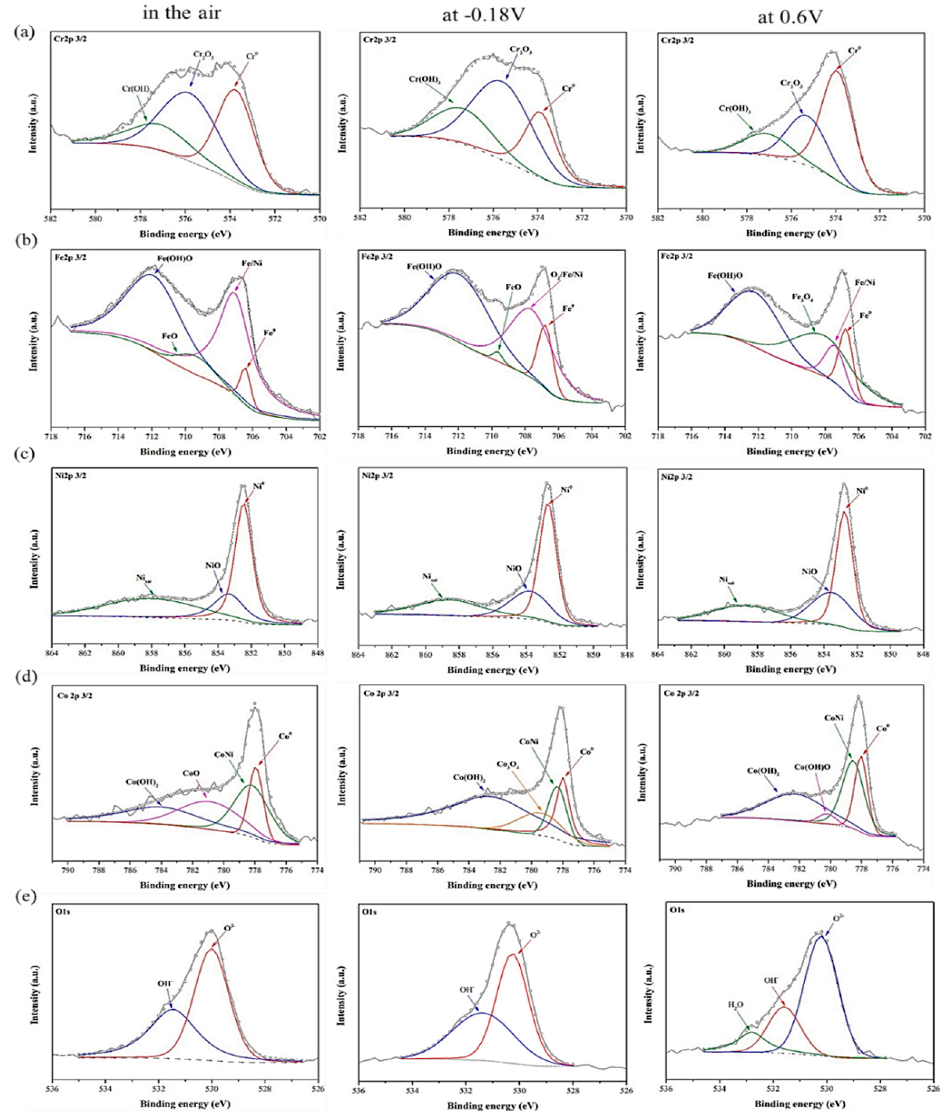
Figure 7. High resolution XPS spectra of the passivation films formed in the air, at E corr1 ( − 0.18V) (Ag/AgCl) and at 0.6 V(Ag/AgCl) in 0.5 M H 2 SO 4 AAS, ( a ) Cr 2p 3/2 , ( b ) Fe 2p 3/2 , ( c ) Ni 2p 3/2 , ( d ) Co 2p 3/2 and ( e ) O 1s on the surface of CoCrFeNi HEA.